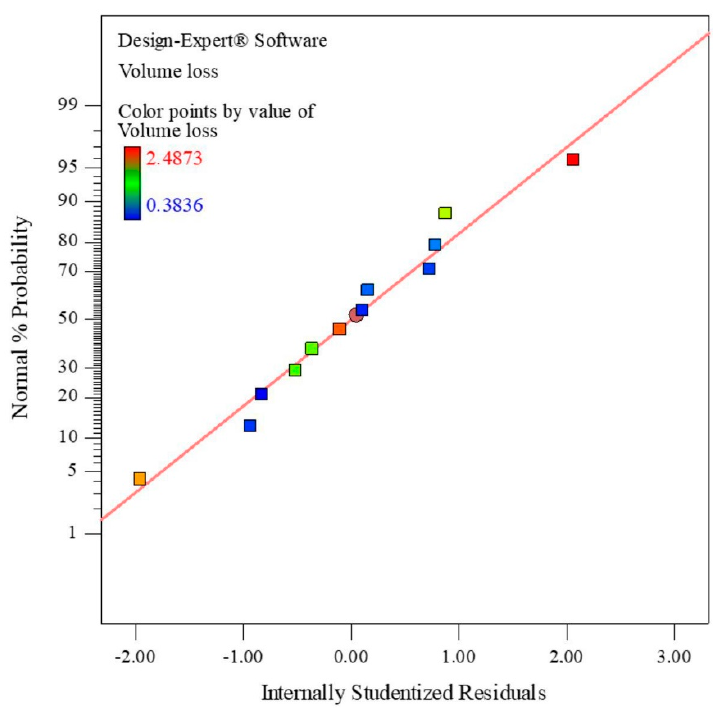
Figure 6. Normal probability plot of internally studentized residuals.